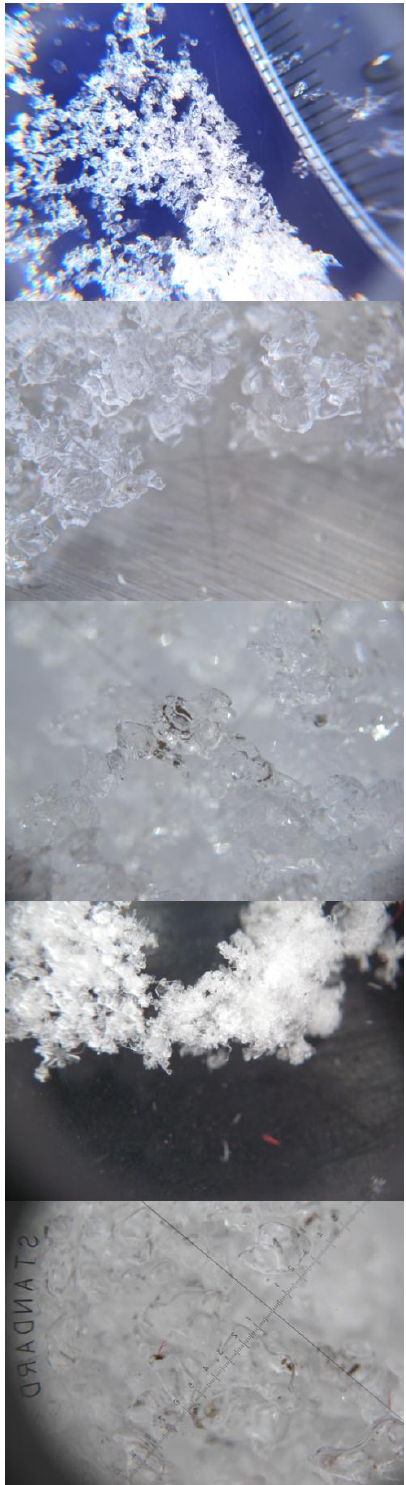
Figure 8. The normalized intensity of the incidence angle measurements. The air temperatures at each day Figure 6. The images of the snow of the following dates (top were: Nov 22: -7°C (new snow), Nov 30: -13.9°C, down): 12th March 2009, 23rd, 27 th , 28 th , and 29th Dec 2: -2.5°C (rounded grains), Jan 10: +1.5°C (wet April 2009, showing the change in crystal structure snow), Jan 18: +0.6°C (wet snow, recent rainfall). in April 28. The millimetre scale is visible in the The field of view of the scanner is highest and lowest images.